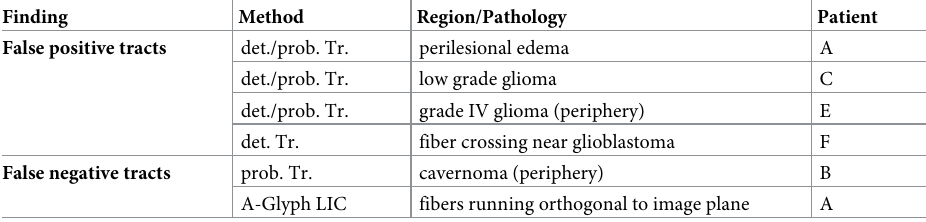
Table 3. List of findings (false positives and negatives) and their relation to the three visualization methods.